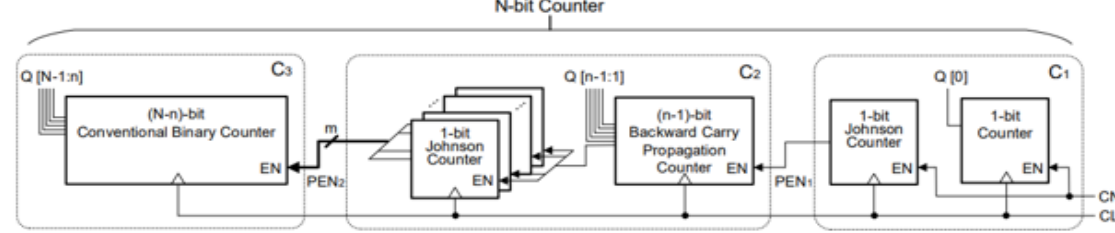
Figure 3 . Schematic of proposed N- bit